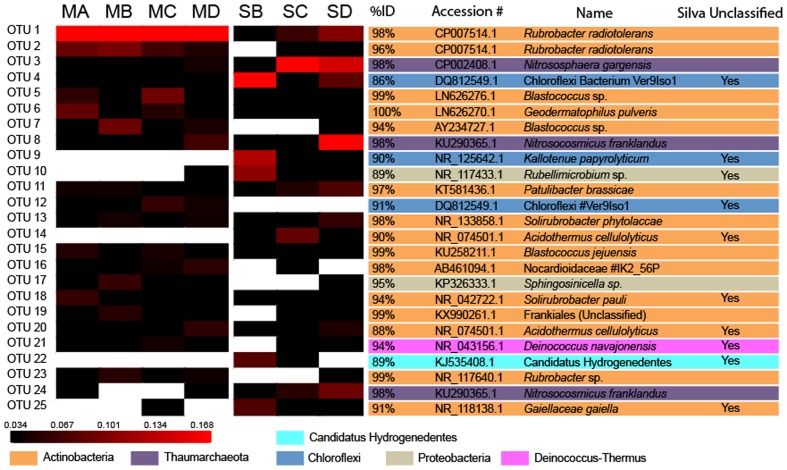
Heatmap of Operational Taxonomic Unit Abundance. Heatmap analysis of OTU abundance in meteorites and soil samples. Analysis performed for OTUs at a distance of ≤0.03. The scale bar represents the fractional abundance of each OTU within each sample. The identity score, accession number, and the name of the nearest named isolate according to NCBI BLAST are indicated beside the heatmap. OTUs that were unable to be classified beyond the level of the domain Bacteria in the Silva database are also noted.